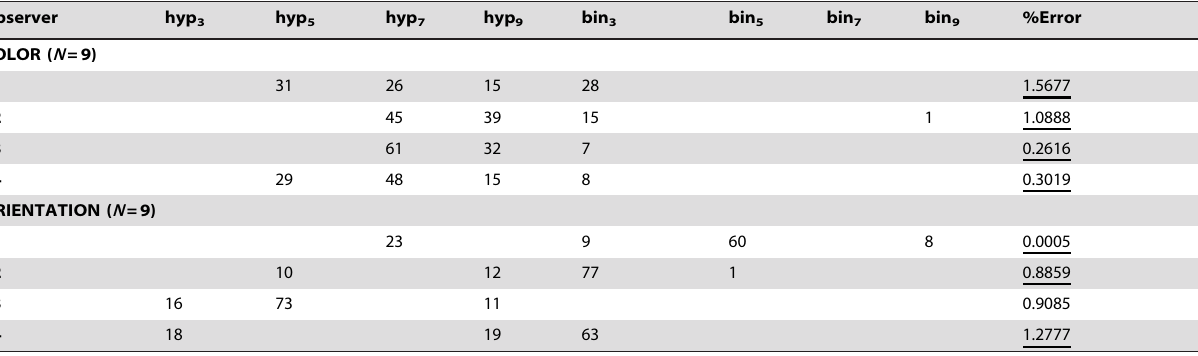
A. The combinations of theoretical hypergeometric and binomial models providing the best fit to the empirical psychometric functions ( N =9). Observer